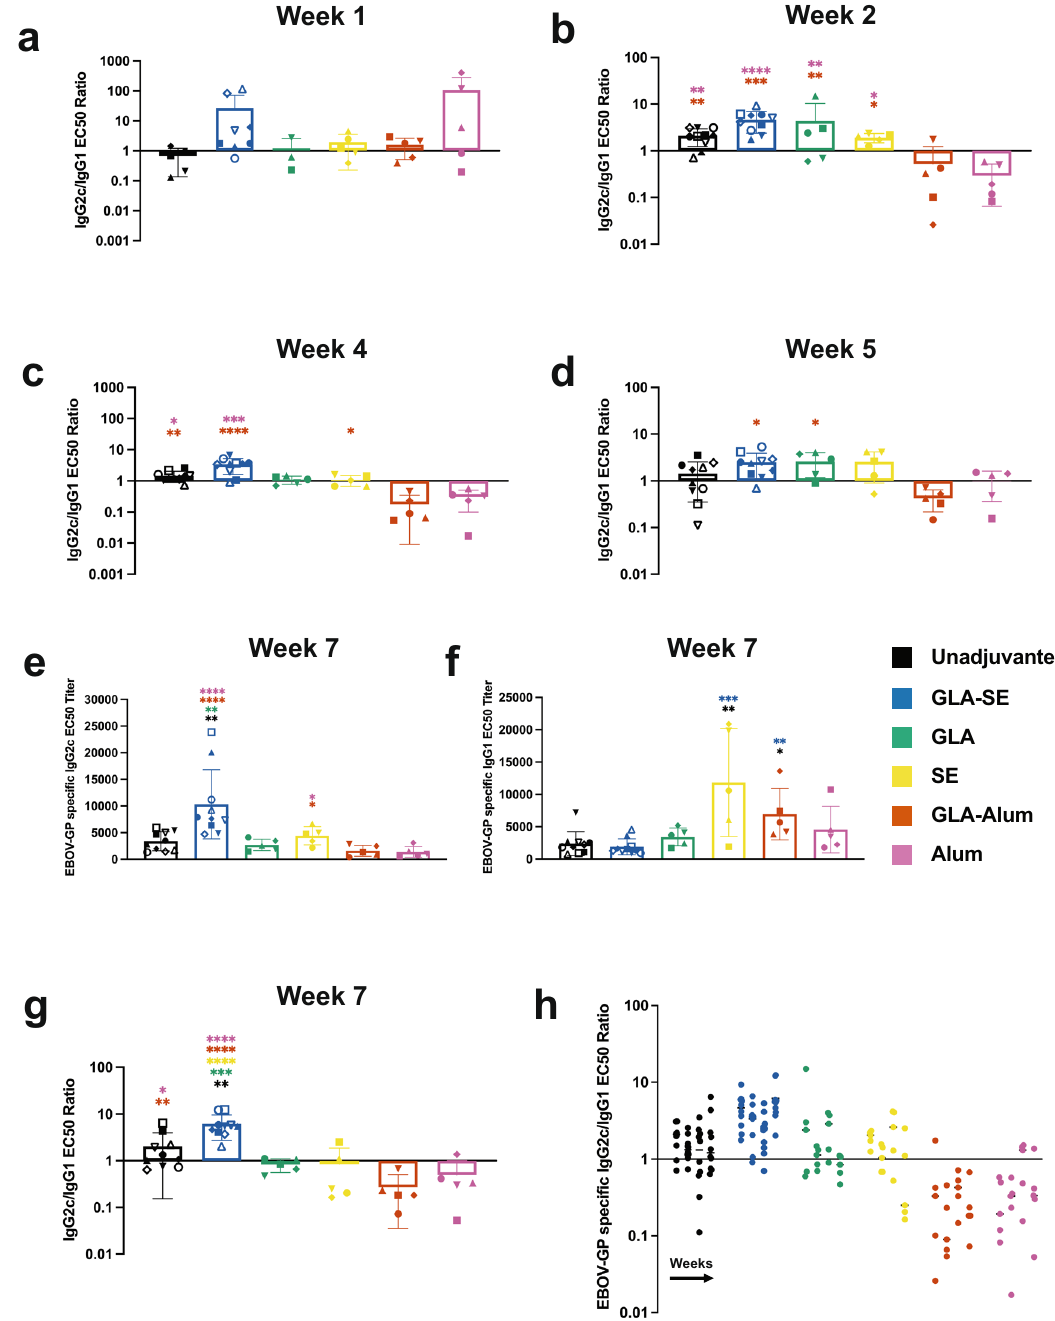
Fig. 2 Th1/Th2-associated EBOV-GP speci fi c antibody responses are highly affected by adjuvant formulation. a Ratio of IgG2c/IgG1 EBOV- GP speci fi c EC50 titer of sera from mice immunized with FILORAB1 unadjuvanted or with GLA-SE, SE, GLA-alum, or alum at 1 week, b 2 weeks, c 4 weeks, d 5 weeks post-immunization reported as average half-maximal effective concentration (EC50) titer (bars) determined from individual mouse serum (symbols) ELISA curves. e EBOV-GP speci fi c IgG2c and f IgG1 speci fi c antibody titers at 7 weeks post-immunization. g Ratio of IgG2c/IgG1 EBOV-GP speci fi c EC50 titer at week 7. h Ratio of IgG2c/IgG1 EBOV-GP speci fi c EC50 titers over time from 2 to 7 weeks post-immunization with each cluster representing an adjuvant group and each column of the cluster a week from 2 to 7. Error bars represent SD from the mean. Statistics are by one-way ANOVA with post hoc Tukey ’ s test of log-transformed EC50 titers. p > 0.1234 (ns), p < 0.0332 (*), p < 0.0021 (**), p < 0.0002 (***), p < 0.0001 alum adjuvanted mice that had protection rates of 20%. Mock higher viremia than GLA-SE adjuvanted mice post-infection. Of the infected mice maintained weight with undetectable viral RNA in seven surviving GLA-SE adjuvanted mice, fi ve had viral RNA titers the blood (Fig. 5b). GLA-SE immunized mice had less weight loss one to threefold lower than the other adjuvant groups, and the compared to other adjuvant groups (Fig. 5c). Mice transferred other two mice had undetectable viremia, which was evidence for unadjuvanted, SE, and alum immunized sera had signi fi cantly the role of antibody-mediated protection in this system.